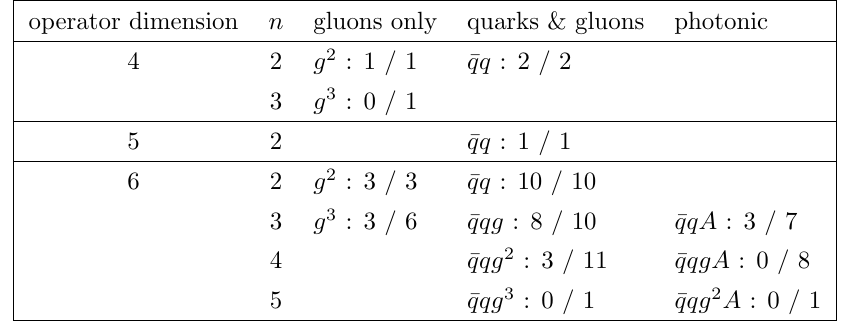
Table 2 . Overview of the available n -point functions with up to one photon. a / b indicates that a constraints are used out of b linearly independent ones provided by the n -point function at O ( e